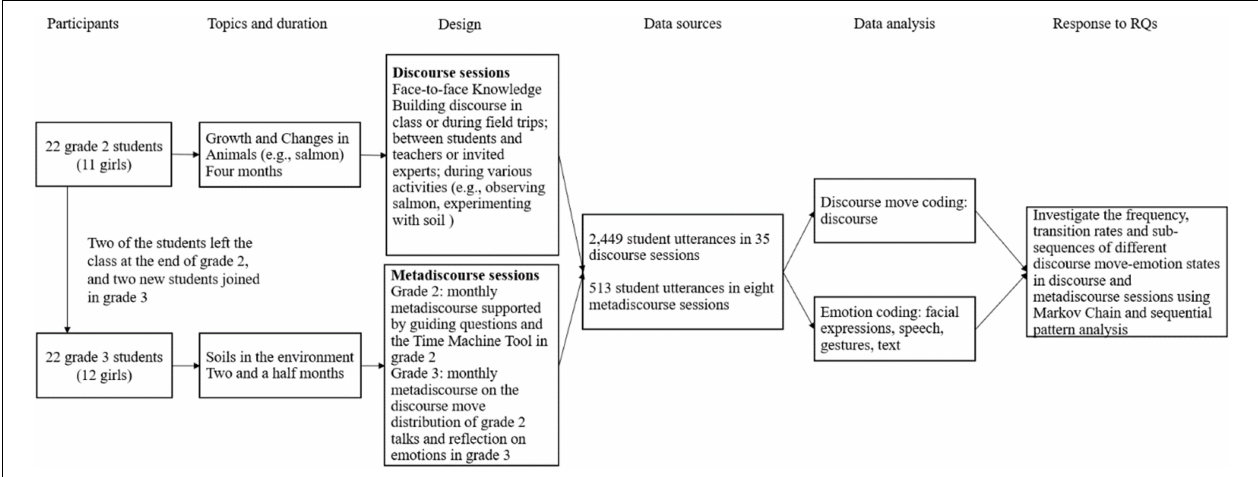
FIGURE 8 | Diagram of the study